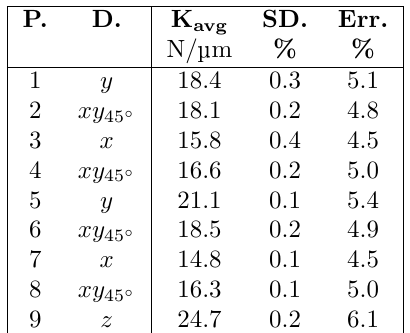
Figure 15: 3-axis CNC, test 1.3: two force application cycles.